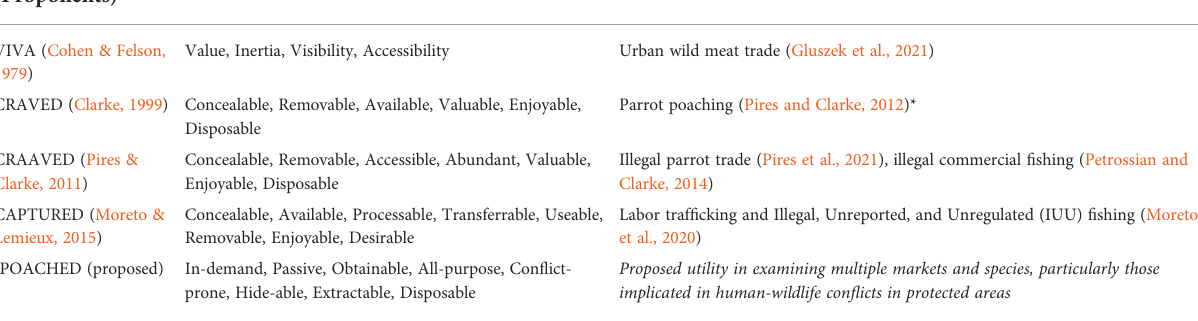
TABLE 1 Evolution of target suitability models use in conservation criminology. Model